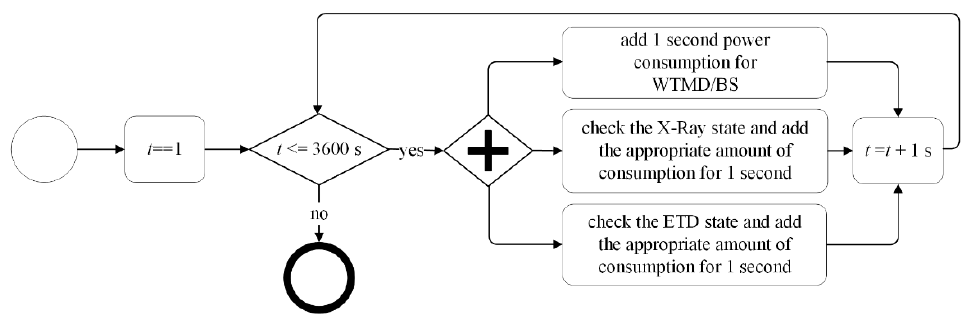
Figure 5. Algorithm for determining power consumption.